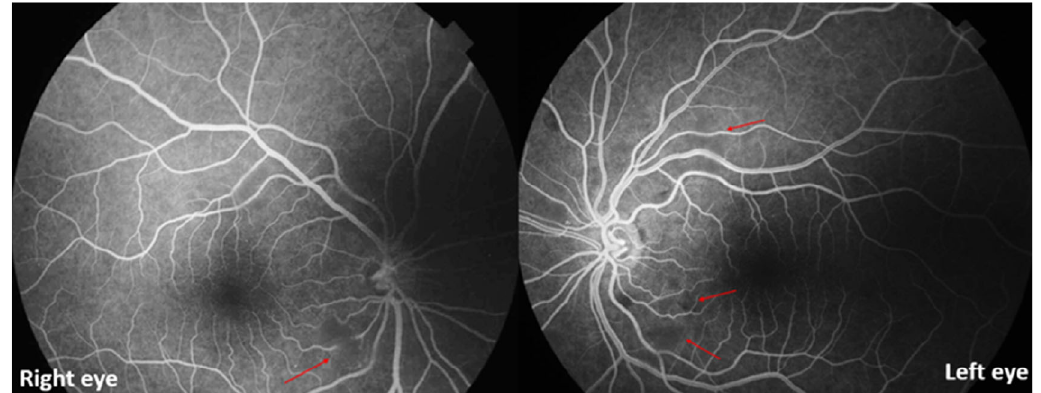
Figure 4. Fluorescein angiography demonstrated mild obscuration of the retinal vasculature in areas of cotton wool spots (red